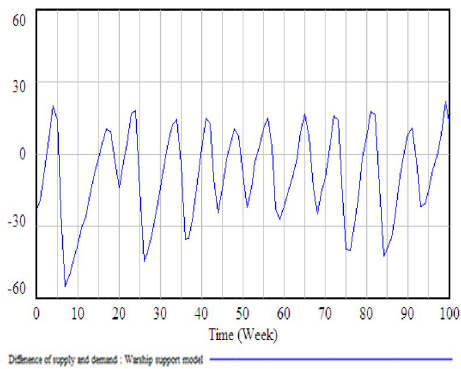
Figure 8. Difference of spare parts supply and